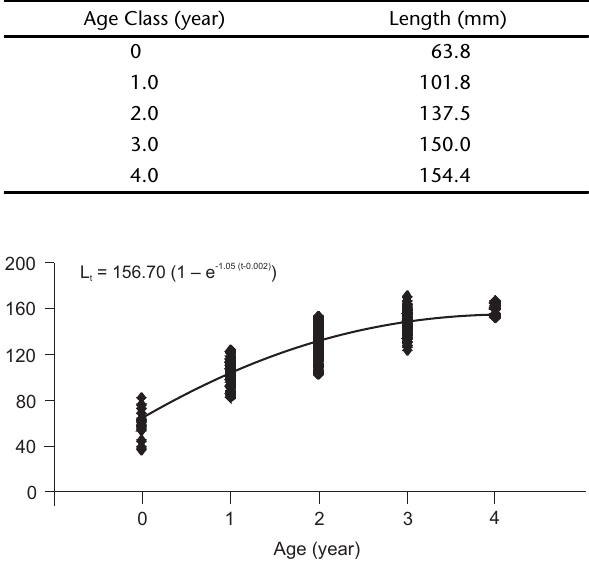
Figure 6. Von Bertalanffy growth curve obtained from the growth parameters determined by the iterative method for C. edentulus in the Saco dos Limões bight (southern Brazil).